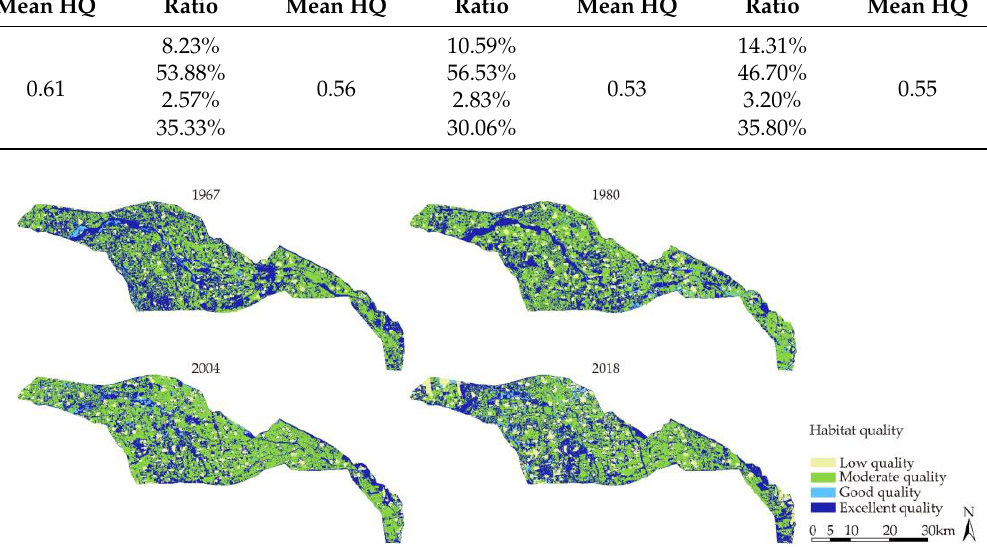
Figure 7. Spatial distribution of habitat quality during 1967 – 2018.